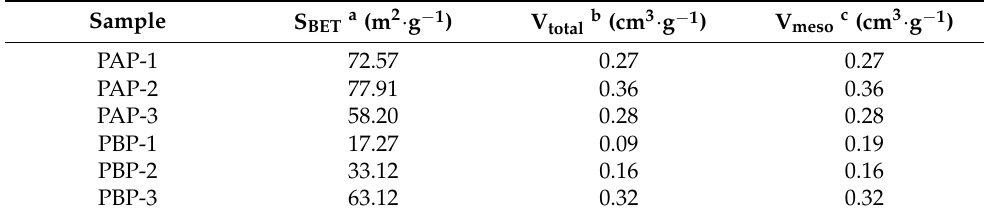
Figure 9. N 2 adsorption and desorption curves of PAP ( a ) and PBP ( b ) samples. Table 1. Specific surface area and pore volume of PAP and PBP